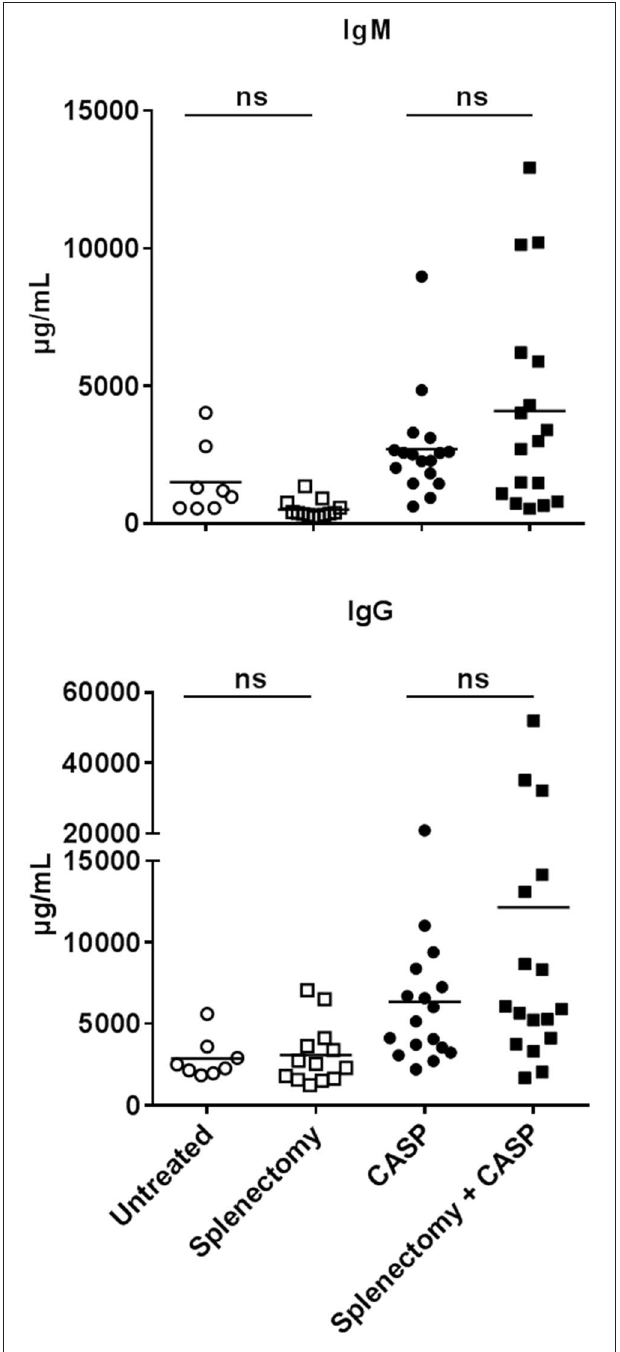
FIGURE 3 | Serum IgM and IgG concentration 14 days after sepsis and splenectomy. Female C57BL/6 mice were CASP-operated and their spleen was explanted in parallel. Untreated, splenectomized-only and CASP-only animals served as controls. 14 days later animals were anesthetized and blood was collected. IgM and IgG serum concentrations were measured by Luminex ® -technology. Shown is the mean of the collective data from two independent experiments with a similar tendency. We used the One Way ANOVA and Bonferroni post-hoc test for selected pairs for statistical evaluation. * p < 0.05; N = 8–17 per